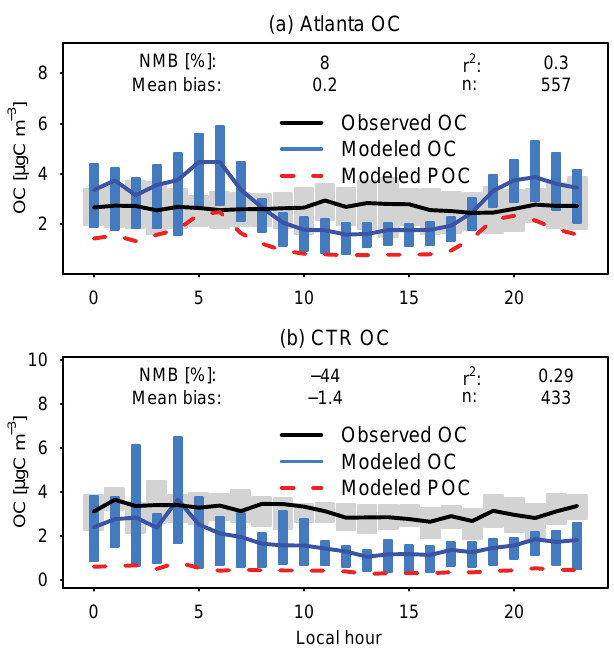
Figure 8. OC as a function of hour of the day for a SEARCH urban (Atlanta, JST) and rural (CTR) site during June 2013. Bars/shading indicate 25th to 75th percentiles. Lines indicate means. Red dashed lines indicate model-predicted